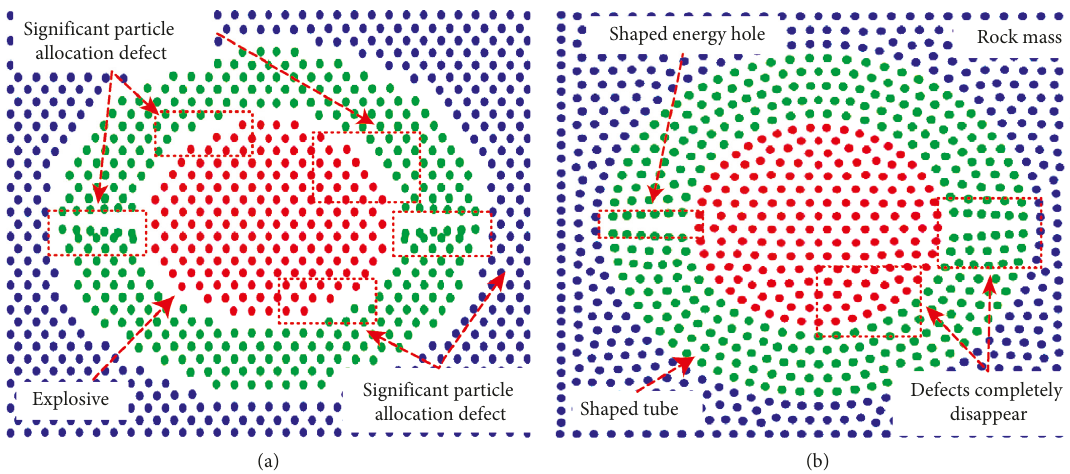
Figure 3: Differences in the particle distribution between the conventional method and the automatic adaptive optimization method. (a) Particle layout using the conventional method. (b) Particle layout using the automatic adaptive